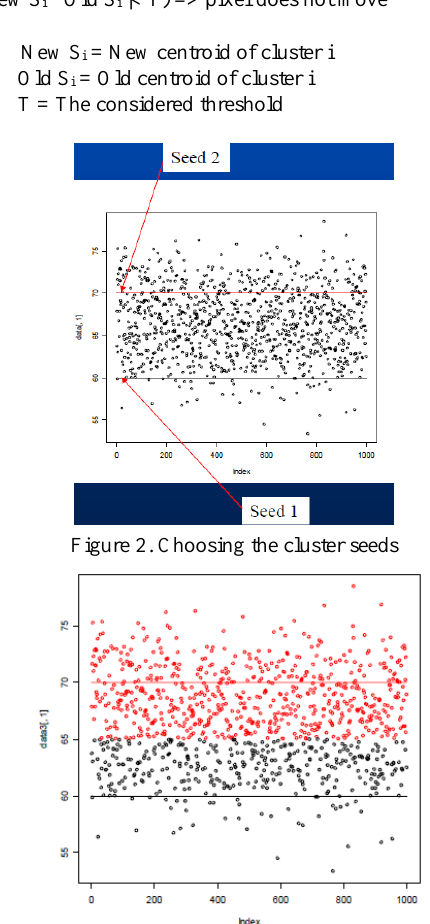
Figure 3. Allocating each object to the nearest